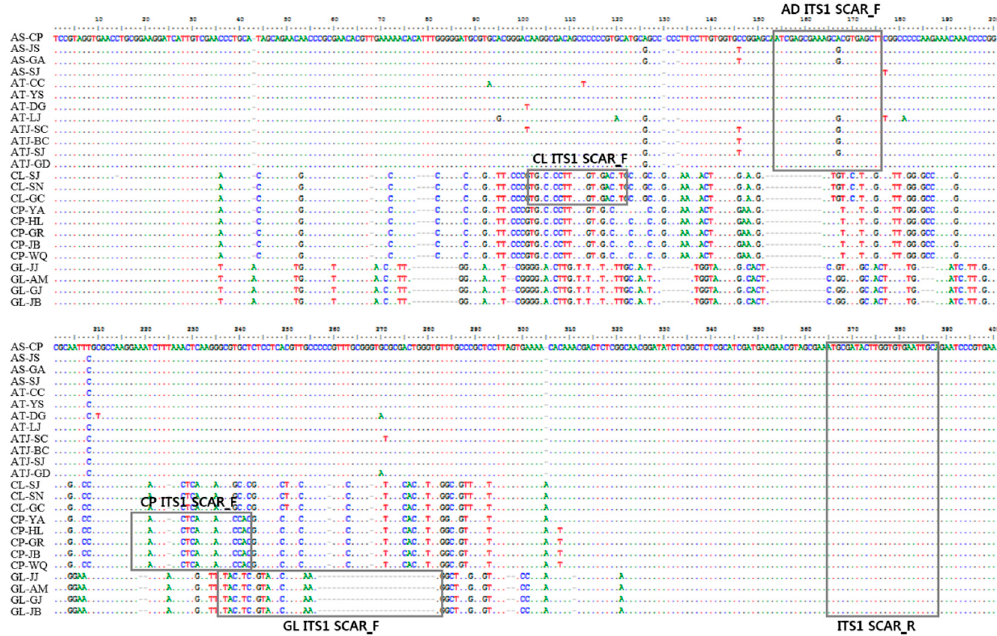
Figure 1. Comparative analysis of ITS1 region sequences and the positions of species-specific primers. Sequences were aligned using ClustalW in BioEdit (version 7.2.6). Boxes indicate the sequence of SCAR (sequence-characterized amplified region) primers used in the multiplex SCAR assay. Primer names are indicated under or above the boxes.